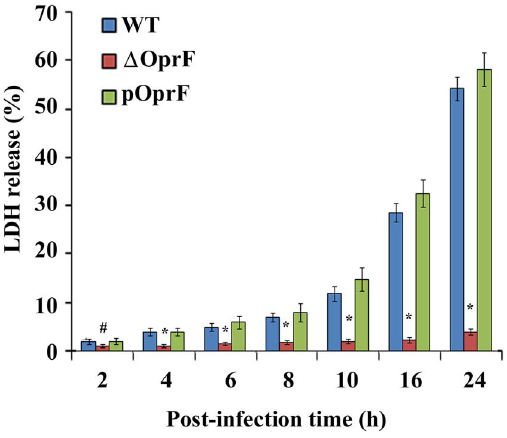
Figure 9. LDH release by HMEECs infected with P.aeruginosa . HMEECs were infected with P. aeruginosa at an MOI of 10 for varying time periods and LDH levels were determined in the culture supernatants of infected cells. Results were expressed as the percentage compared with maximum LDH release by lysed cells. Data represents mean 6 SD and is representative of five individual experiments carried out in triplicate. # P , 0.05 or *P , 0.001 compared to WT or